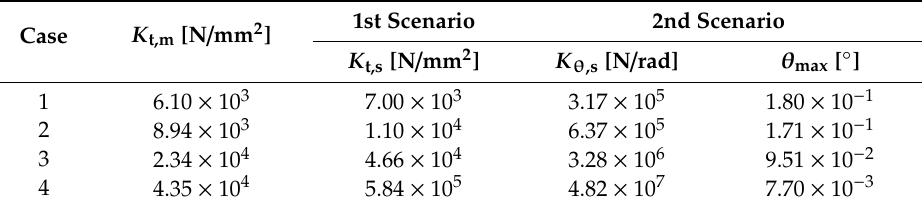
Table 4. Summary of the four cases analysed in first and second scenario using a flat-to-flat with rounded edges contact